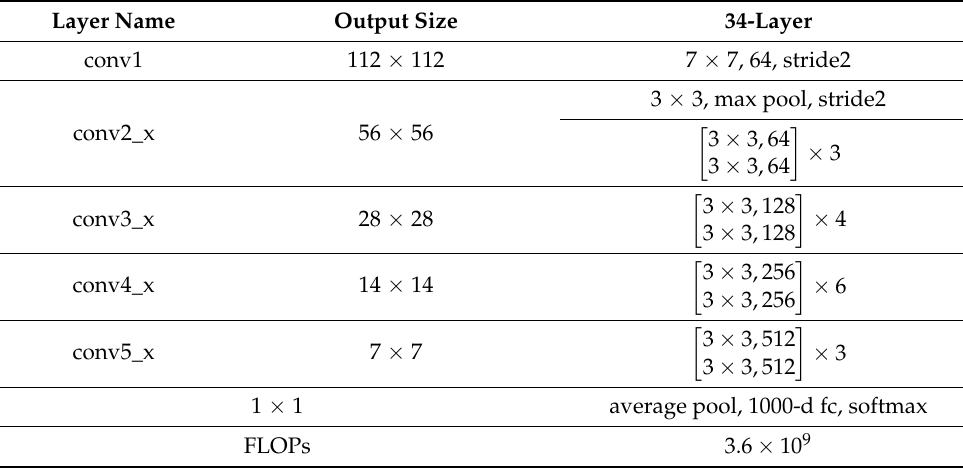
Table 2. Parameter table of each layer of deep residual network.